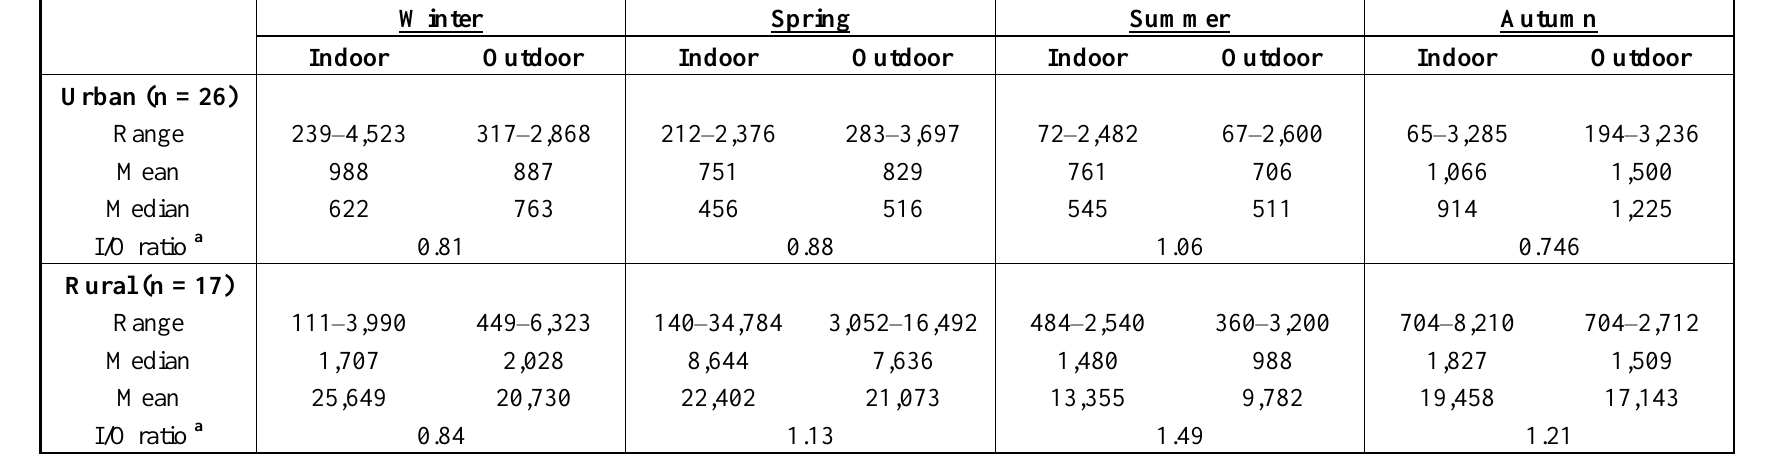
Table 3. Total Indoor and outdoor range, mean and median fungal concentrations (colony forming units per cubic meter of air), and Indoor/Outdoor ratio by